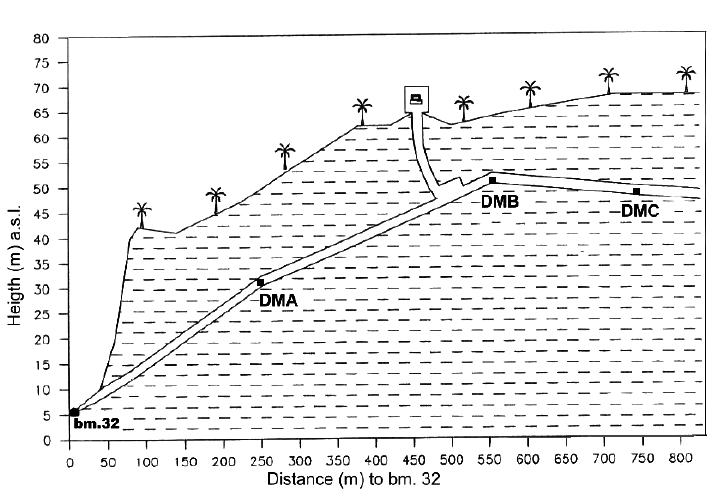
Fig. 5 . Topographical section of subsurface gallery in Pozzuoli and the DMA, DMB, DMC position.